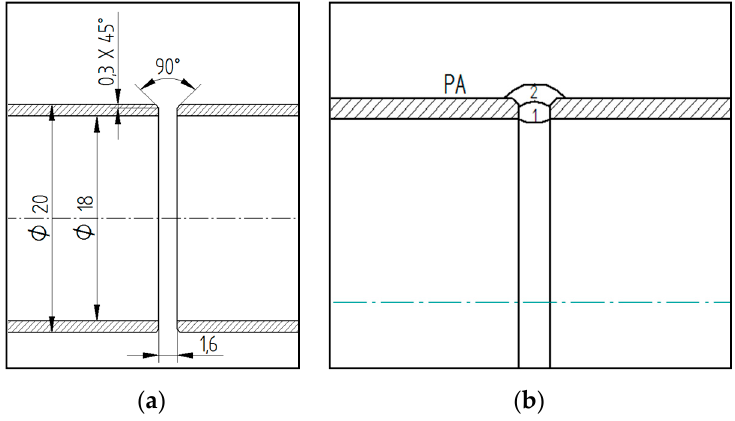
Figure 2. ( a ) Weld surface preparation and ( b ) method of laying weld beads.